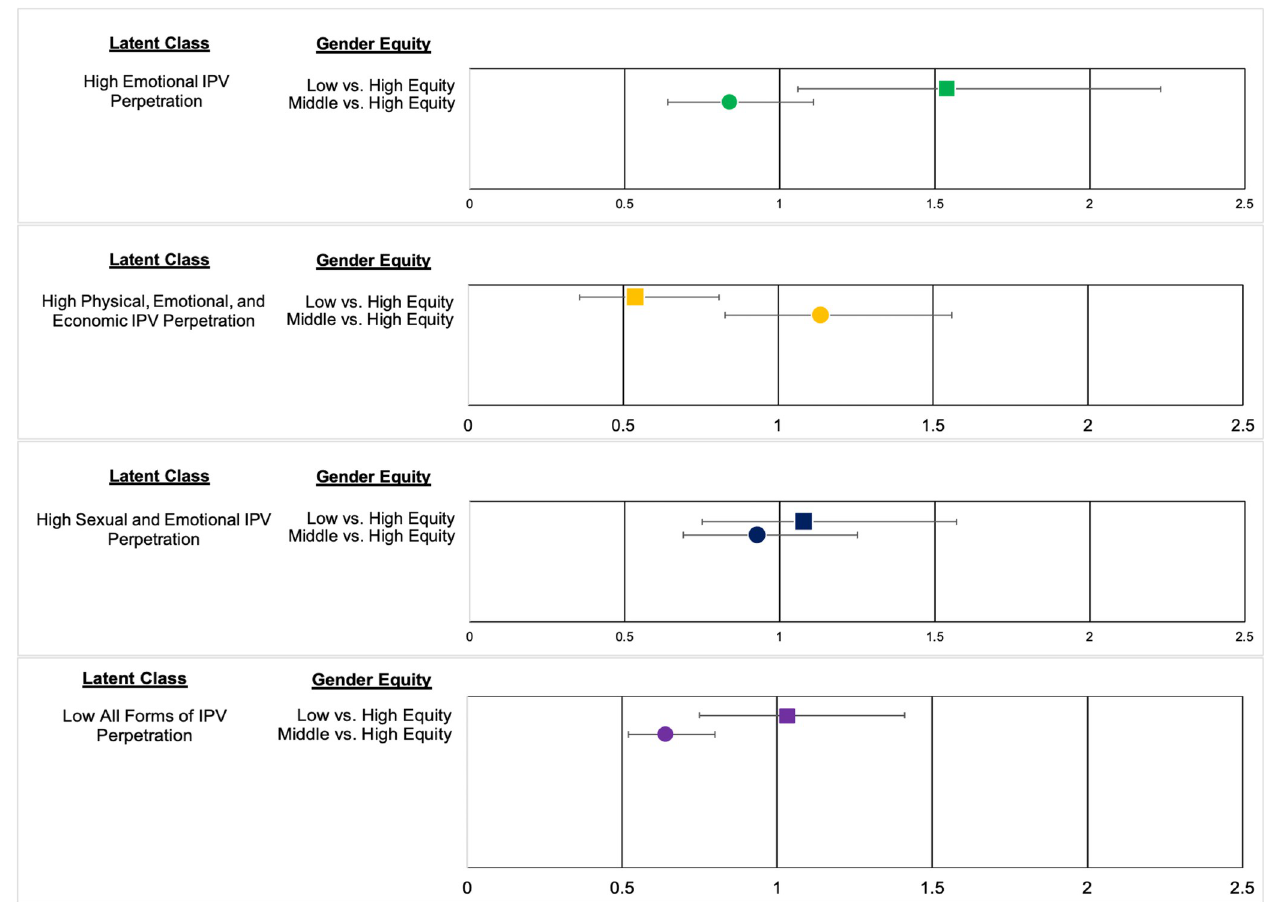
Fig 2. Associations between latent classes and gender equitable attitudes among male participants recruited for UN Multi-Country Study on Men and Violence (total sample). Note . High All Forms of IPV Perpetration latent class is not shown because it is the reference group. Covariates include age, education, employment, married/cohabitating, whether they had kids and accounted for multistage